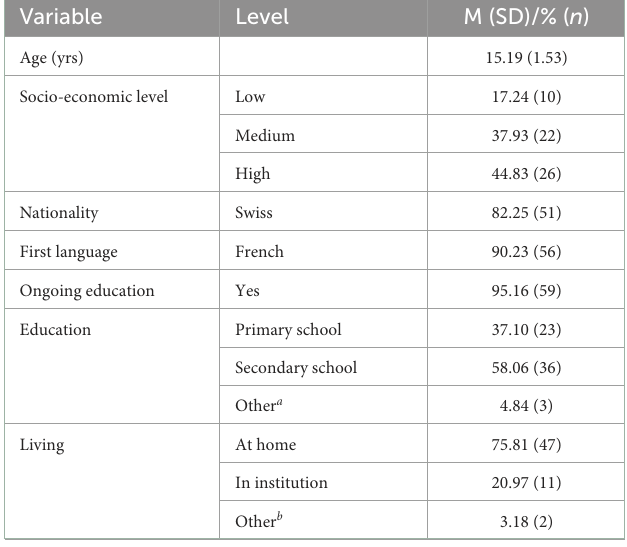
TABLE 1 Socio-demographic characteristics ( n =